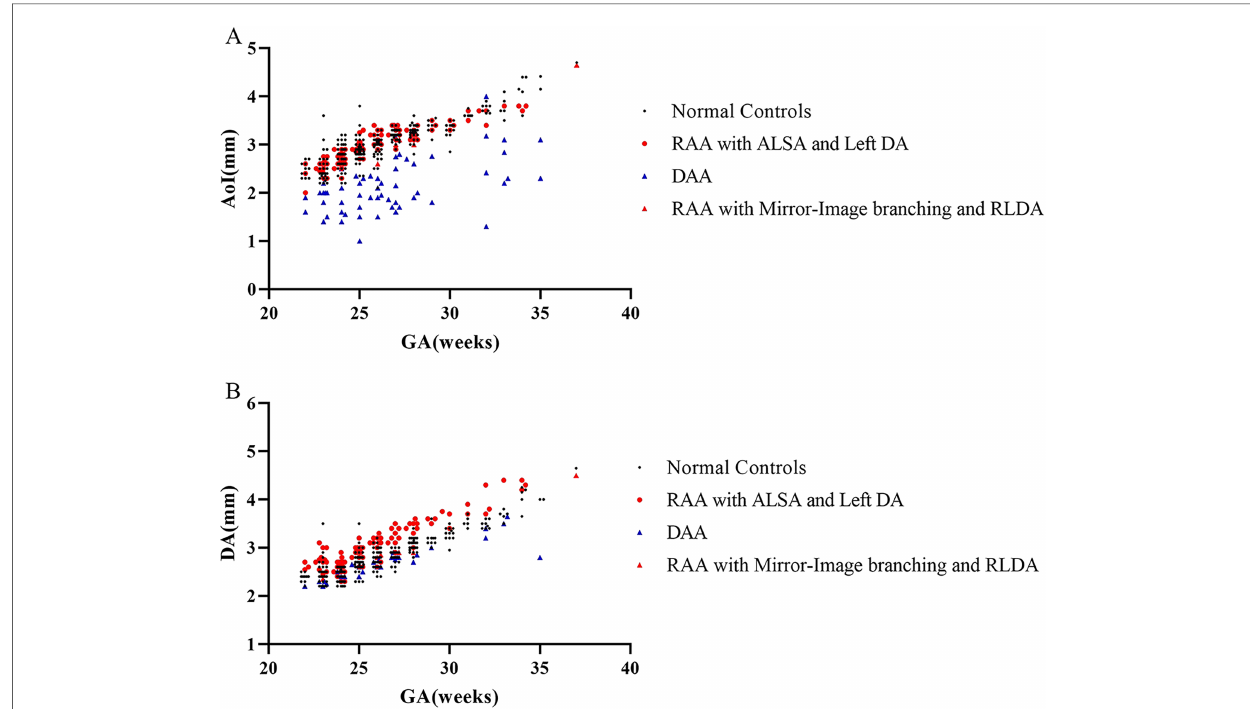
FIGURE 5 ( A,B ) Distribution of vascular diameters against gestational age measured by fetal MRI. Individual measurements of the diameters of AoI and DA in 130 CVR fetuses and 260 normal controls fetuses were plotted. ( A ) Scatter plot showed the relationships between diameters of AoI and GA in normal control group and three subgroups of CVR; ( B ) scatter plot showed relationships between diameters of DA and GA in normal control group and three subgroups of CVR. AoI, aortic arch isthmus; DA, ductus arteriosus; GA, gestation age; RAA with ALSA and left DA, right aortic arch with aberrant left subclavian artery and left ductus arteriosus; DAA, double aortic arch; RAA with mirror-image branching and RLDA, RAA with mirror-image branching and retroesophageal left ductus arteriosus.